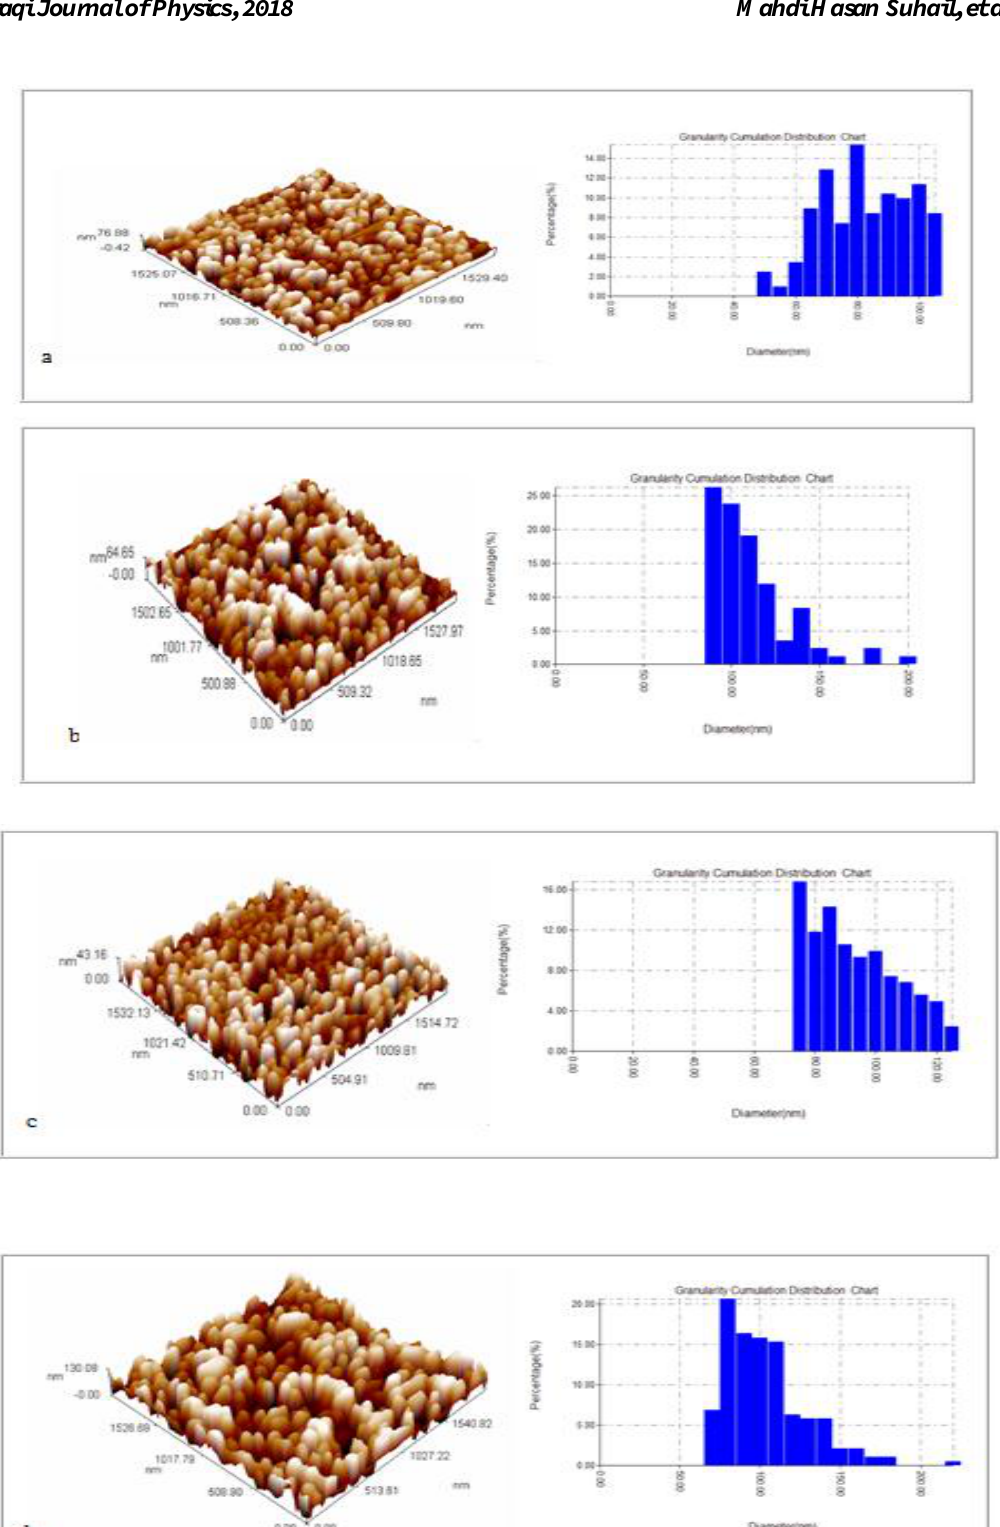
Fig. 4: Atomic force microscopy for Cr